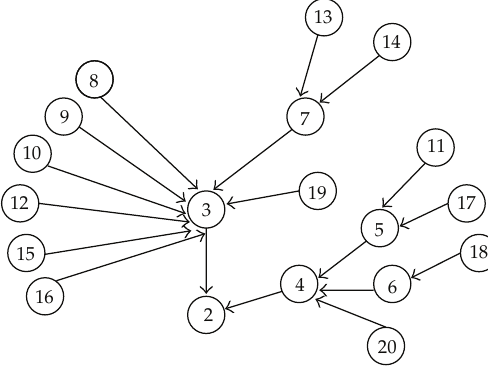
Figure 1: The 3 x (cid:2) 1 map expressed as values of k ≤ 20 for endpoints (cid:3) 2 k − 1 (cid:4)